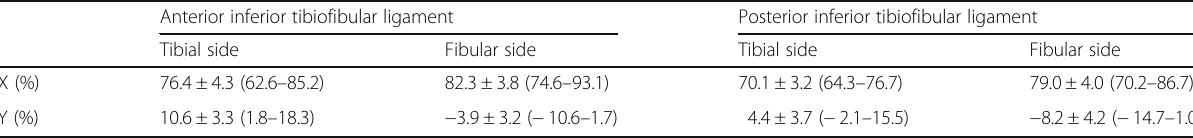
Table 3 Location coordinates on anterior and posterior views of three-dimensional images Anterior inferior tibiofibular ligament Posterior inferior tibiofibular ligament Tibial